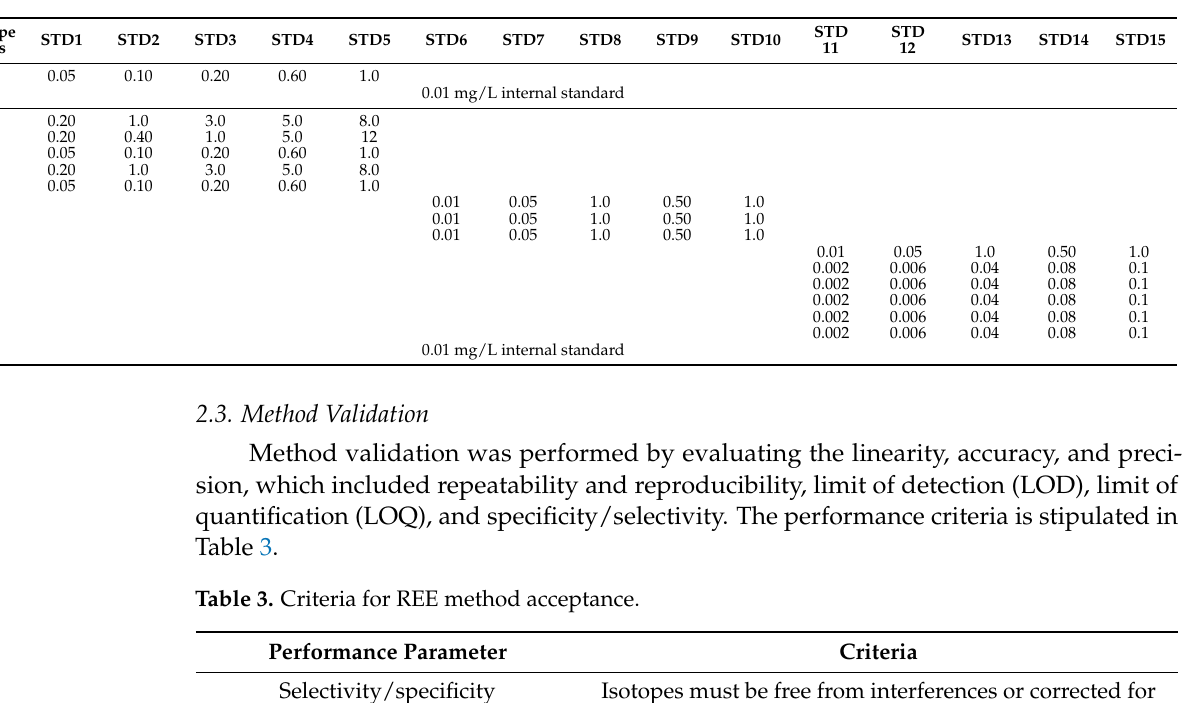
Table 2. Calibration standards in mg/L prepared for REE analysis by ICP-MS.